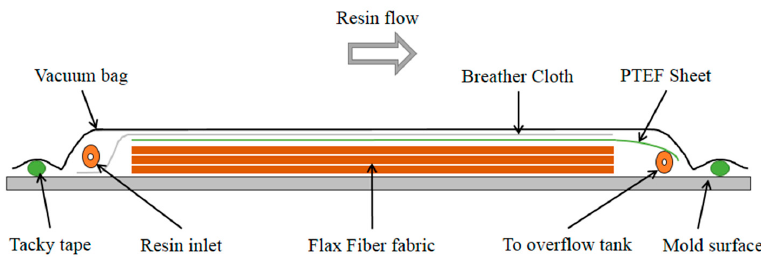
Figure 3. Schematic of the Vacuum Assisted Resin Transfer Molding (VARTM) set-up used to manufacture composite sample.